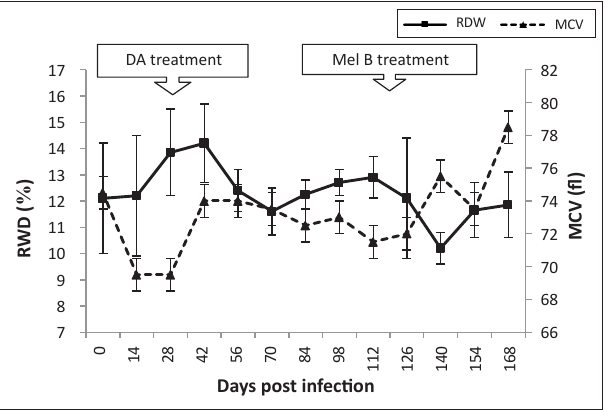
FIGURE 4: Mean changes in red cell distribution width (RDW) and mean cell volume (MCV) of vervet monkeys infected with T. b. brucei GUTat 1, showing the point of subcurative treatment with diminazene aceturate (DA) (28 dpi) and curative treatment with melarsoprol (Mel B) (119 dpi).